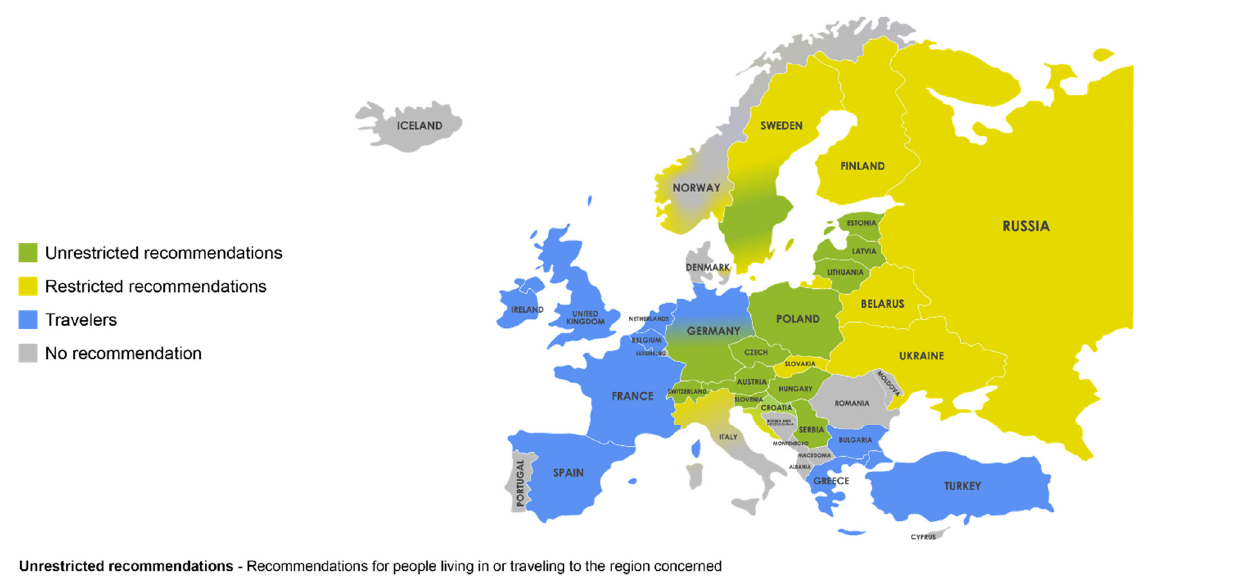
Figure 3. Vaccination recommendations in Europe. Unrestricted recommendation—Recommendations for people living in or traveling to the region concerned. Restricted recommendations —Rec- ommendations for particular high-risk areas, age groups, locations of high incidence, or occupa- tional exposure. Please consult local recommendations. Travelers—Recommendation only for trav- elers. Reprinted with permission from Ref. [10]. Copyright 2021 Global Health Press Pte Ltd. Beyond the abovementioned challenges in defining TBE risk areas, estimating the level of risk of TBEV infection is further complicated by annual variation in the TBEV